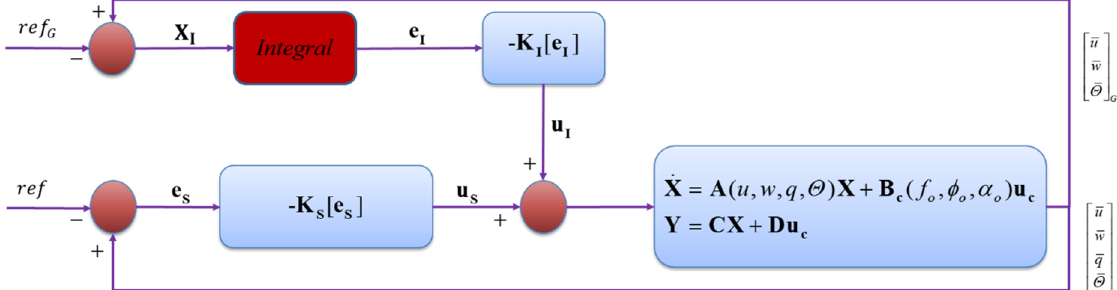
Figure 5. Schematic diagram of gain-scheduled LQR control loop for transition flight tracking of the linear model.